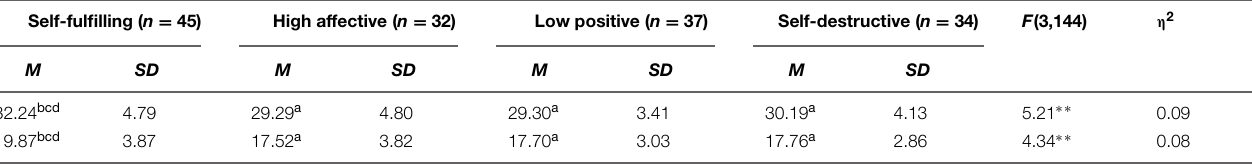
TABLE 2 | Means differences in self-esteem and optimism in affective